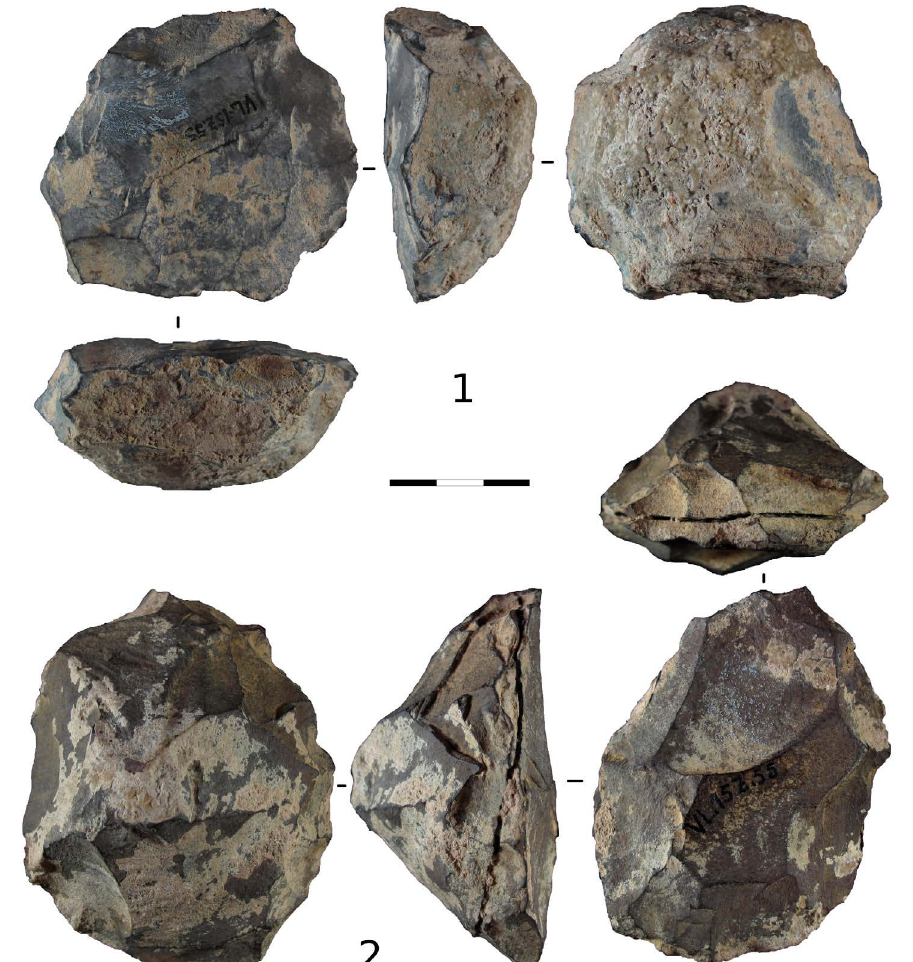
Figure 7. Mudstone flat-convex centripetal cores. Ventalaperra level